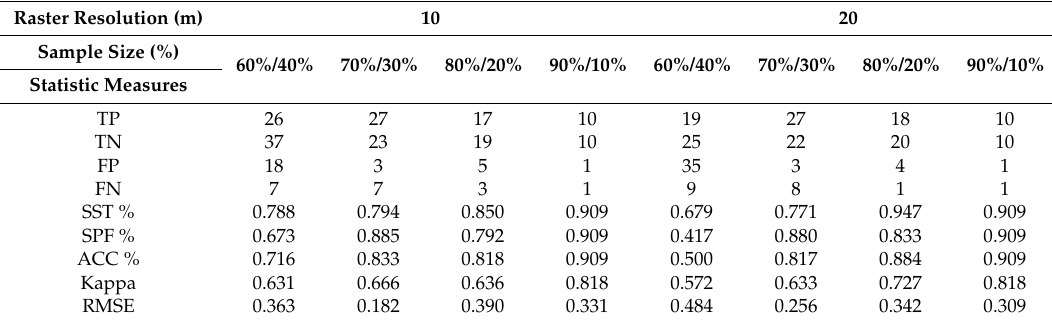
Table 4. Model performance using validation dataset and ADTree algorithm.